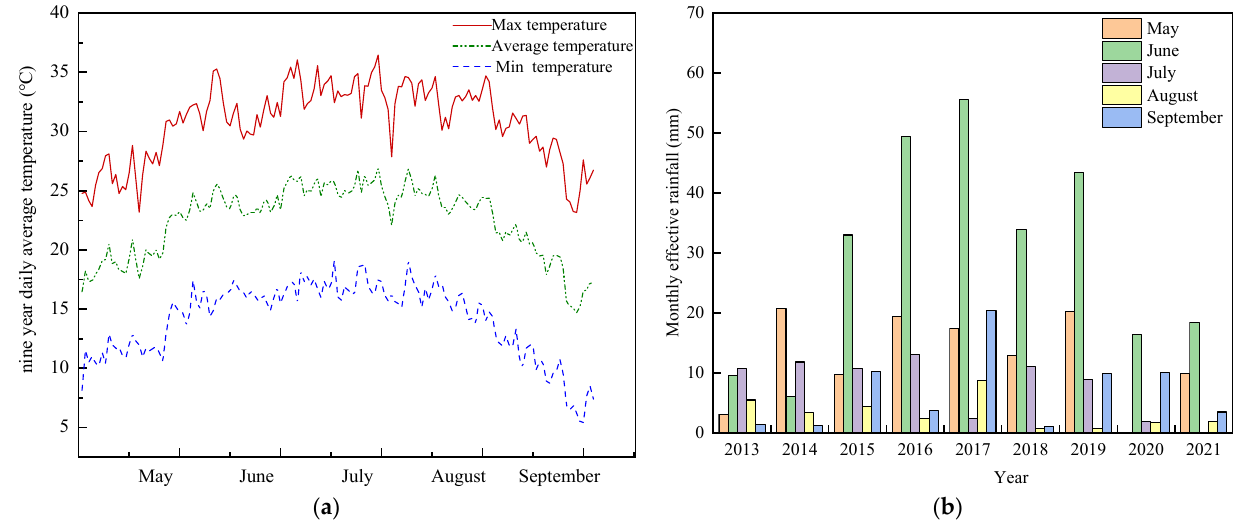
Figure 1. Meteorological variation during maize growth periods from 2013 to 2021. ( a ) Daily average temperature. ( b ) Monthly effective rainfall.